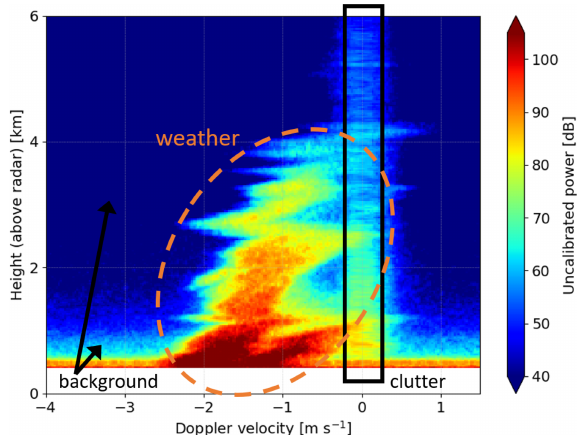
Figure 1. Profile of mean Doppler (power) spectra recorded with MOHp C-band radar in the H polarization channel in one birdbath scan during a snowstorm in the winter of 2020 (data timestamp: 18 January 2020, 00:24:46UTC) after the internal radar signal pro- cessor had already applied a notch filter to mitigate strong clutter near 0ms − 1 for each individual Doppler spectrum.